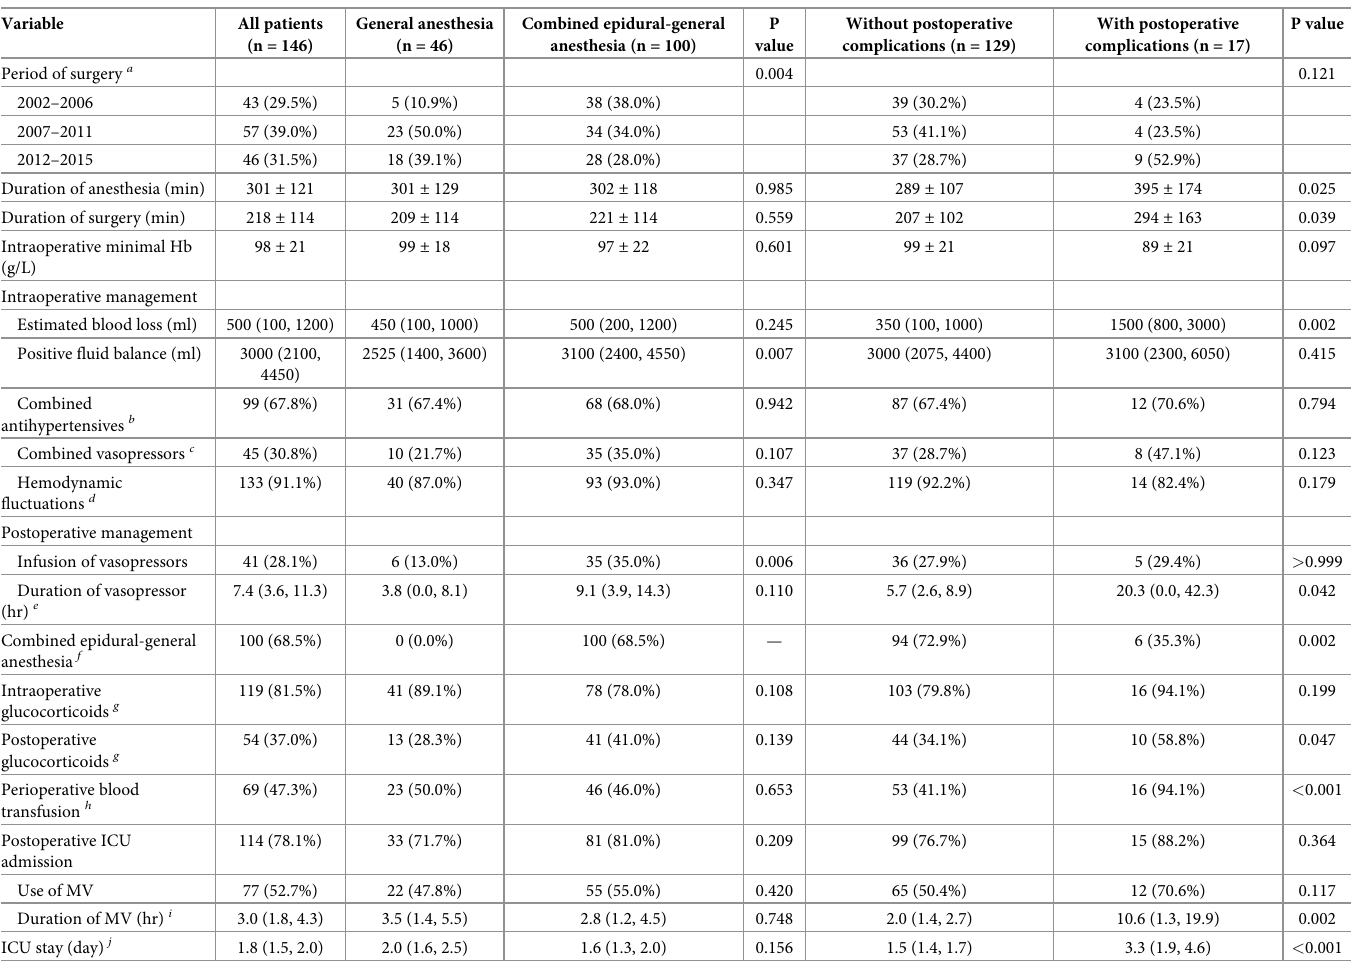
Table 2. Intra- and postoperative